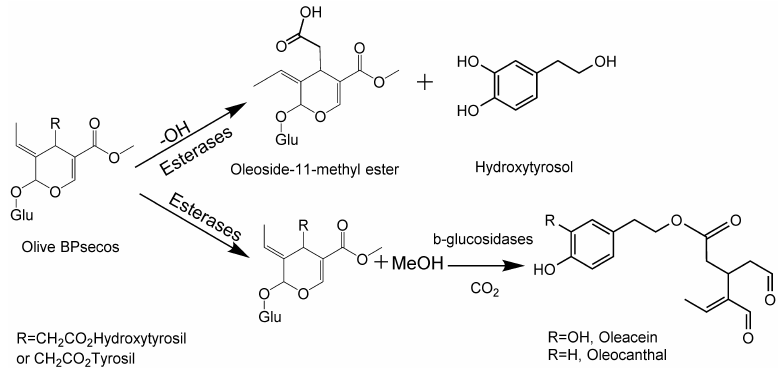
Figure 6. Olive BPseco molecular dynamic sequence under basic and enzymatic catalysis.